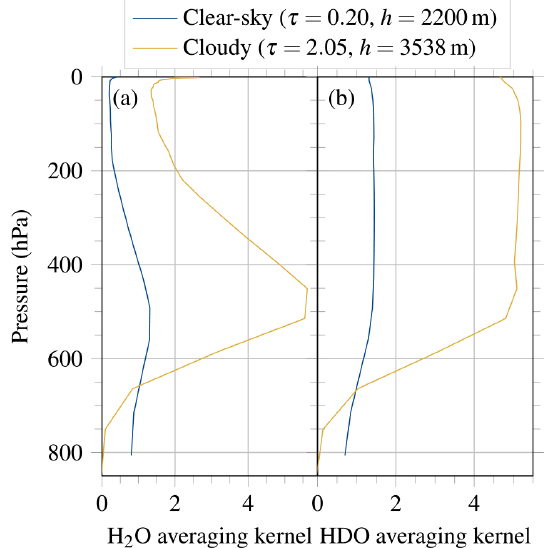
Figure 12. Averaging kernels of (a) H 2 O and (b) HDO for a clear- sky scene (orbit 4725 on 11 September 2018, blue) and a cloudy scene (orbit 4839 on 19 September 2018, yellow) near Zugspitze.